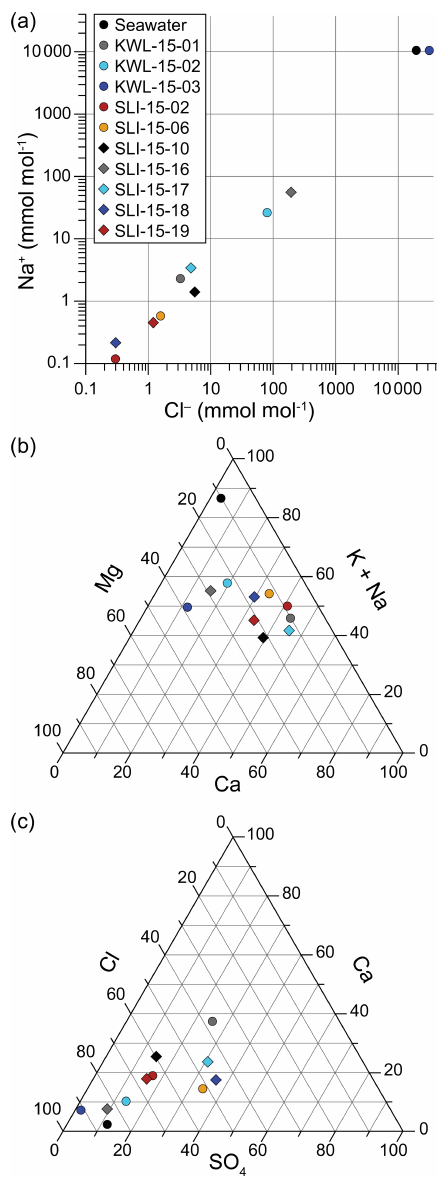
Figure 7. (a) Scatter plot of Na + vs. Cl − in 10 meltwater ponds. Ternary diagrams of (b) Mg 2 + , Ca 2 + , and K + + Na + and (c) Cl − , SO 2 − , and Ca 2 + in meltwater ponds shown as percent by equiva- 4